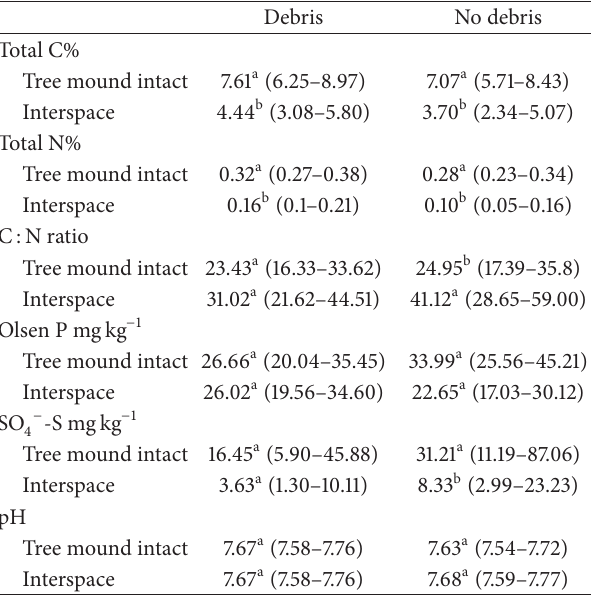
Table 3: Tree mastication and intact tree mound effects on soil nutrients derived from soil samples.